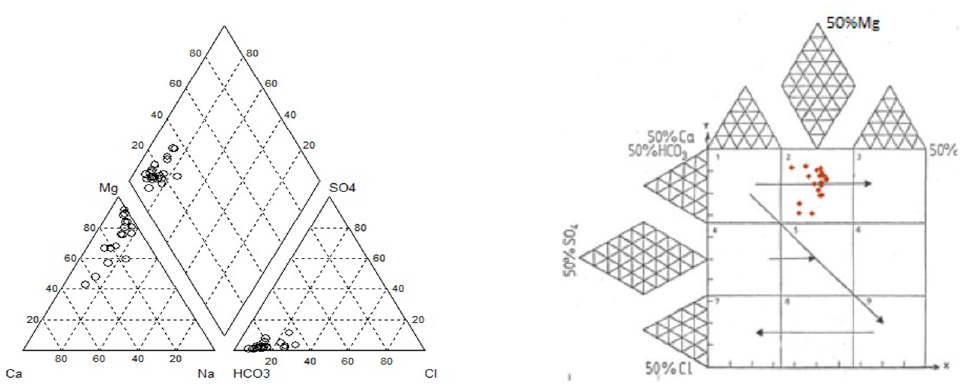
Figure 5. Piper and Durov diagrams.